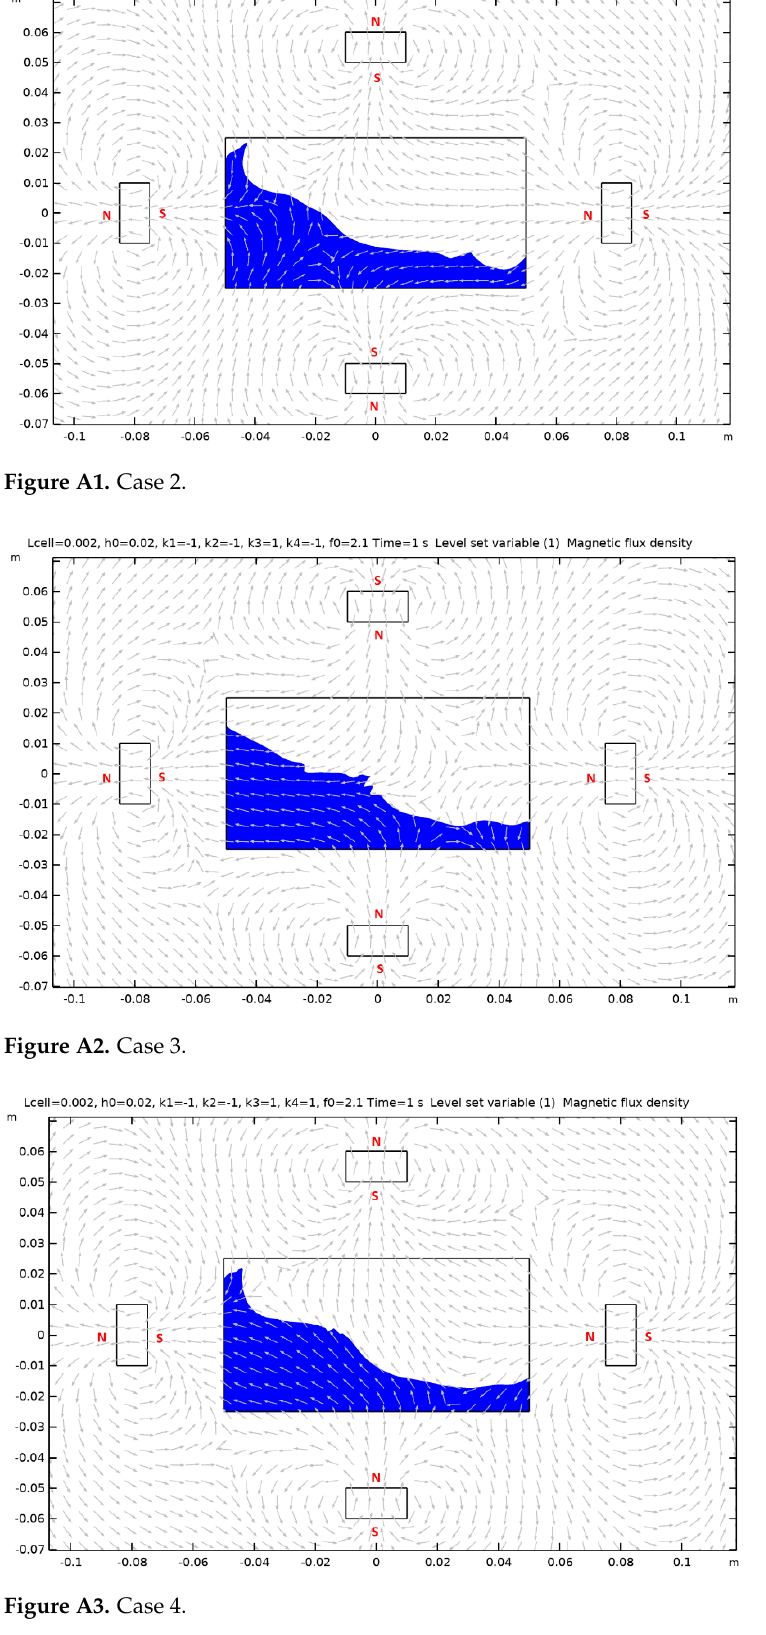
Figure A4. Case 5.